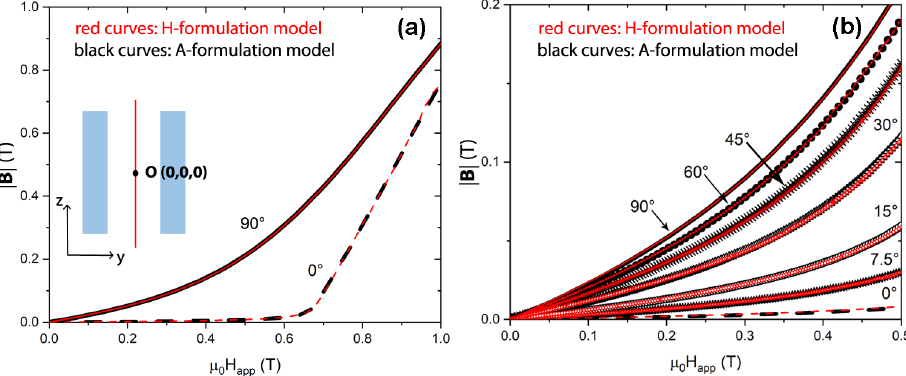
Figure 2. Comparison between the magnetic flux density values calculated in the tube center O (whose coordinates were set to (0,0,0)) of the tubular shield shown in Figure 1 using the H -formulation (red curves) and the A -formulation (black curves). Calculations were carried out in the axial and transverse field orientations ( a ) and for different angles of the applied field ( b ).